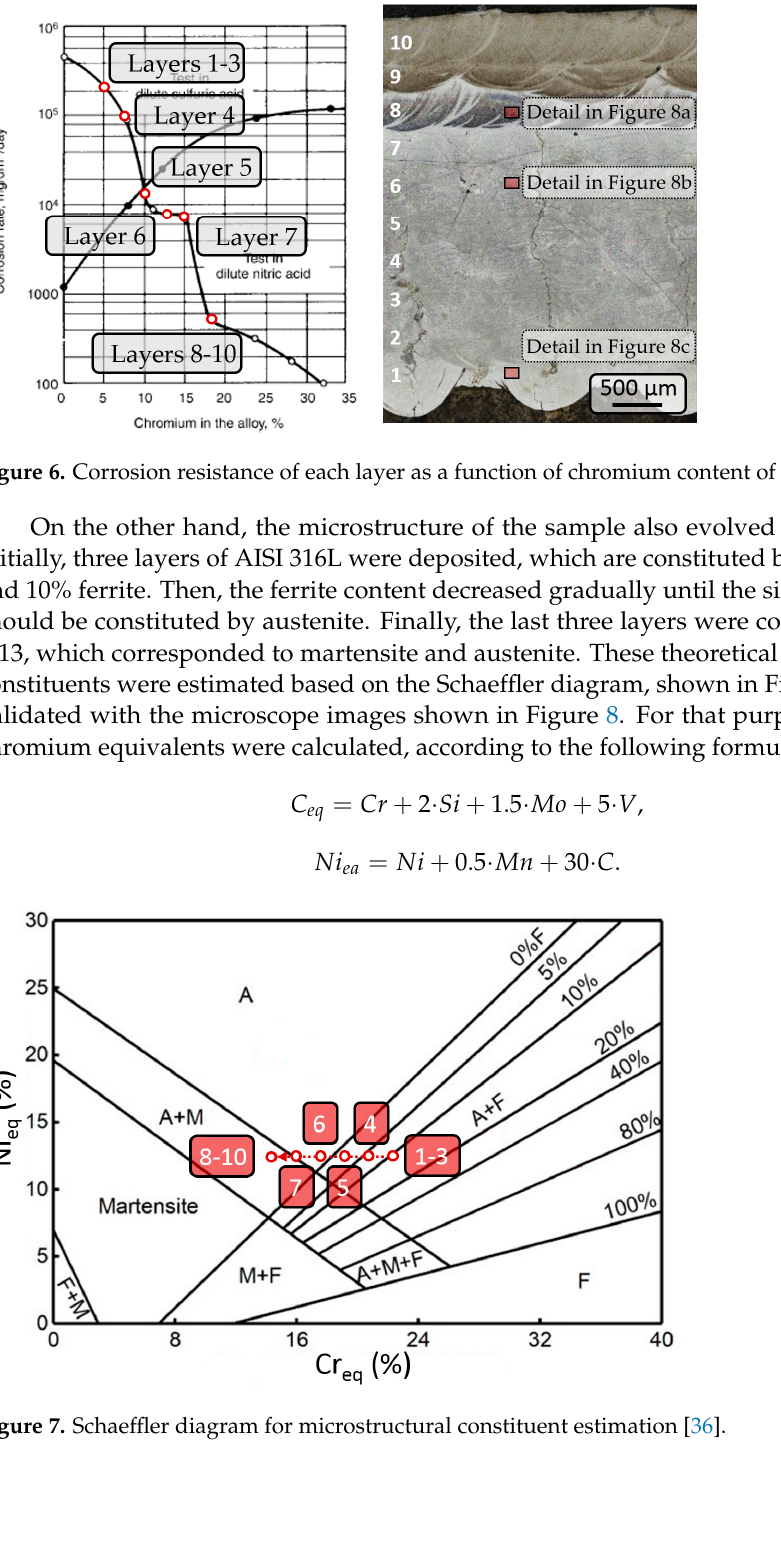
( c ) Figure 8. Microstructure details of the FGM sample along the gradient (specific location shown in Figure 6): ( a ) eighth layer, 100% AISI H13 with its microstructure constituted by martensite and austenite, ( b ) sixth layer, 40% AISI 316L and 60% AISI H13 with mostly aus- tenitic microstructure, ( c ) first layer, 100% AISI 316L with austenite and ferrite constituted microstructure. Finally, as far as the hardness of the sample is concerned, a nonlinear hardness in- crease has been observed from the first layers and up to the last three layers, showing typical cladded AISI H13 hardness values. In Figure 9, the hardness values measured along the building direction of the FGM are shown, and at the same time compared with the maximum attainable hardness of the steels calculated from the carbon content accord- ing to [37,38]. It can be observed that the upper layers, corresponding to the unmixed tool steel, reached the maximum attainable hardness values owing to the formation of marten- site and the characteristic precipitation of the carbides that constitute AISI H13. However, in the graded intermediate layers, the hardness decreased abruptly rather than in a grad- ual manner, as could be expected based on carbon content of the added material. This occurred because the resulting microstructure was also conditioned by nickel and chro- mium equivalents, as it is detailed in the Schaeffler diagram shown in Figure 6. Interme- diate graded compositions promoted austenite formation and, therefore, the resulting hardness was significantly reduced. Also, due to the reduced carbon content, carbide for- mation may be impeded and, consequently, the hardness reduced.